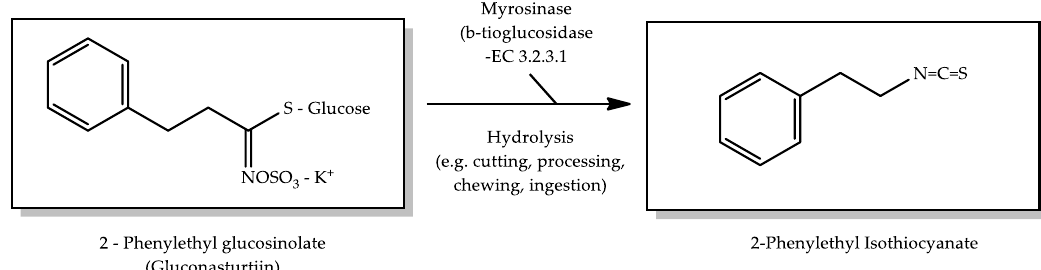
Figure 4. Formation of the 2-phenylethyl isothiocyanate compound through the synthesis of 2-phenylethyl glucosinolate.